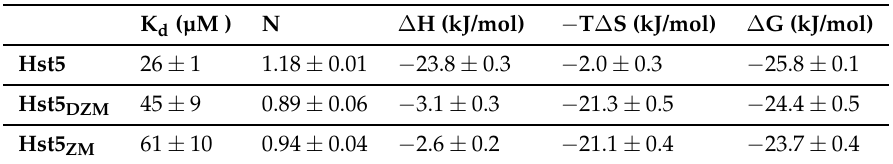
Table 1. Thermodynamic analysis of Zn 2+ binding to Hst5 and variants. All experiments were performed as described under “Experimental Procedures” and represent the average of three independent experiments. K d (µM ) Δ H